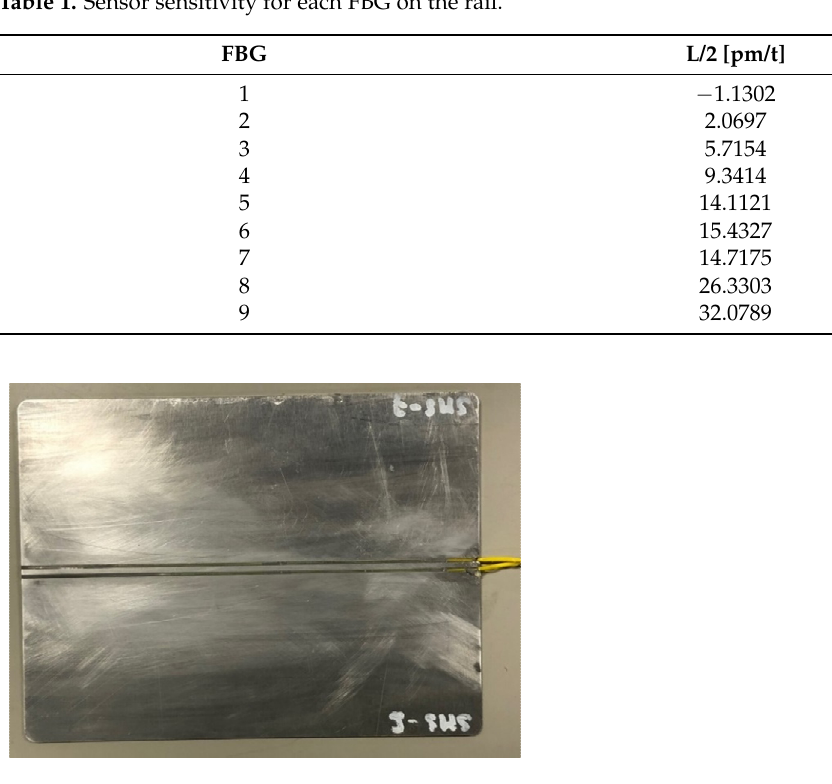
Figure 6 . Picture of the aluminum PAD. Figure 6. Picture of the aluminum